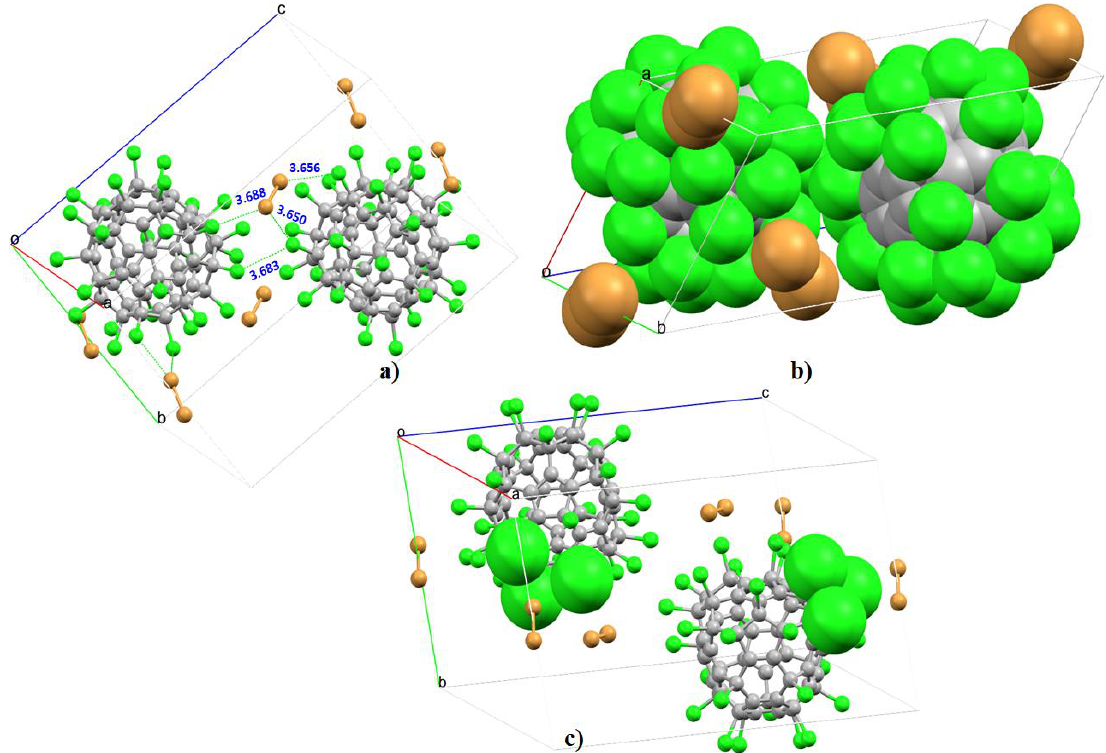
Figure 15. The ( a ) ball-and-stick and ( b ) space-filling models of unit cell of the crystal structure of (C 60 Cl 30 ) 2 ·3Br 2 crystal (CSD ref: FIKHAJ). ( c ) Illustration of space-filling local regions that can be used